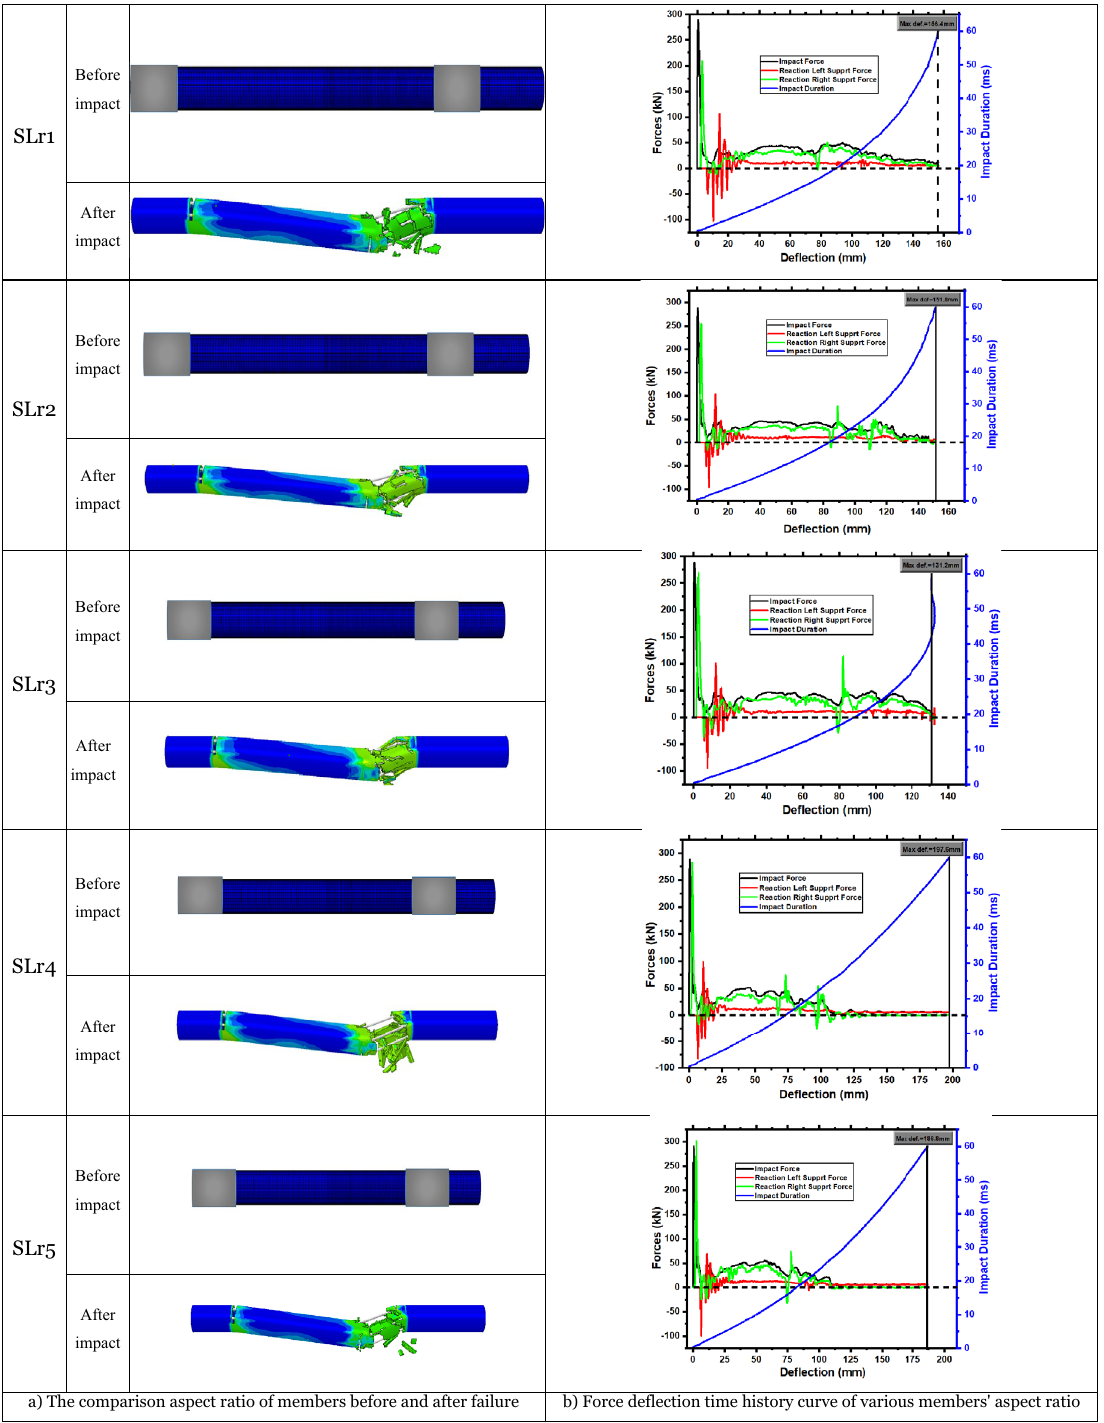
Figure 21. Effect of aspect ratio on the